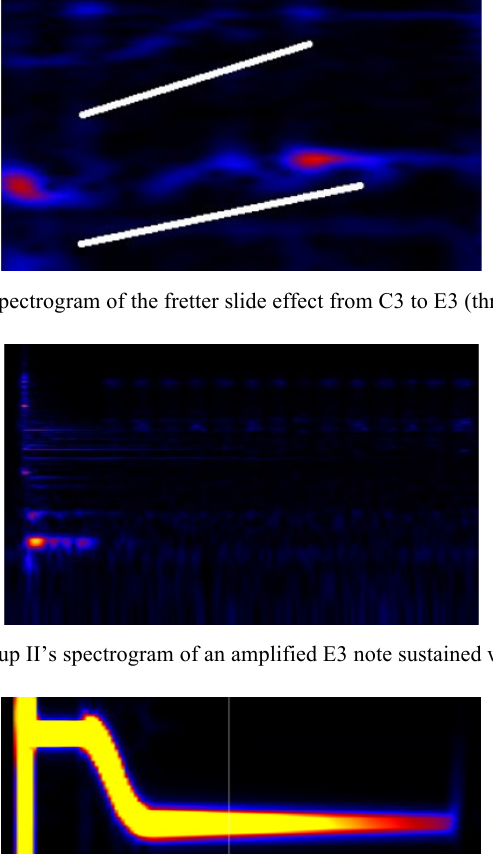
peak of frequency.